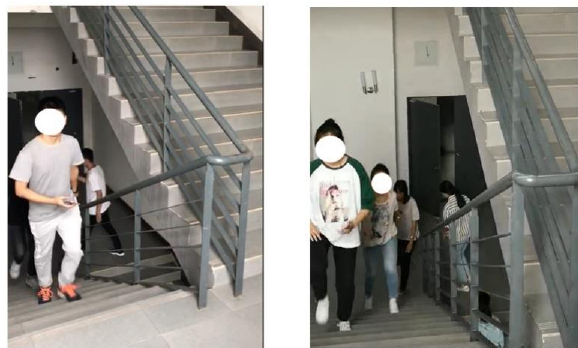
Figure 6. Experimental procedure of Group A.